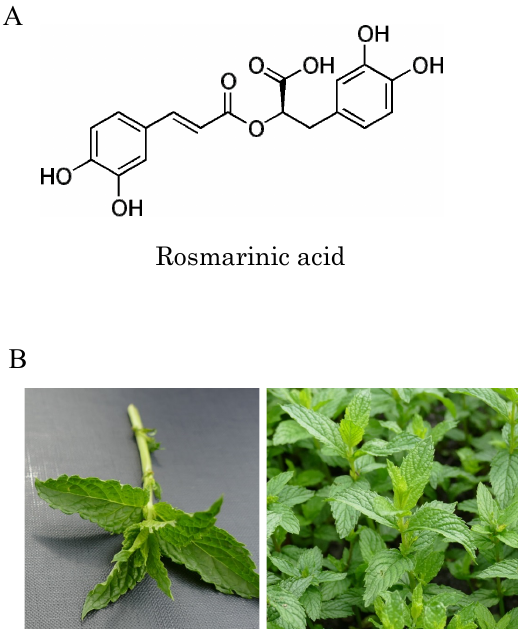
Figure 1. Chemical structure of rosmarinic acid and spearmint leaves: ( A ) chemical structure of rosmarinic acid; ( B ) spearmint ( Mentha spicata L.) cultivated in Indiana, USA contains more rosmarinic acid and phenolic compounds than conventional spearmint due to selective breeding.